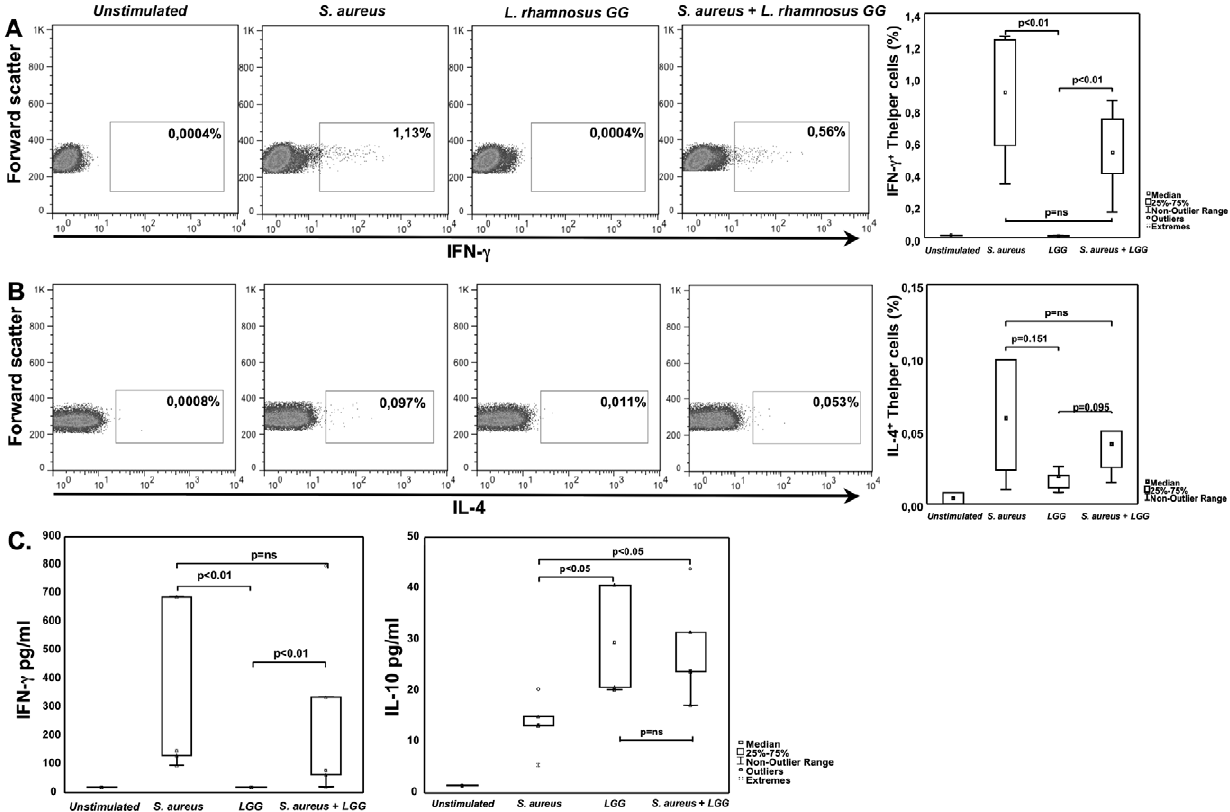
Figure 5. S.aureus supernatant induces IFN- c producing T helper cells and soluble IFN- c after invitro stimulation of PBMCs. In vitro stimulation of PBMCs with S. aureus 161.2 supernatant induces higher percentages of CD4 + T helper cells positive for IFN- c (A) and tends to induce higher percentages of IL-4 + positive CD4 + T helper cells (B). IFN- c and IL-10 released into culture supernatant shown in (C). Data are representative of 5–6 healthy donors.